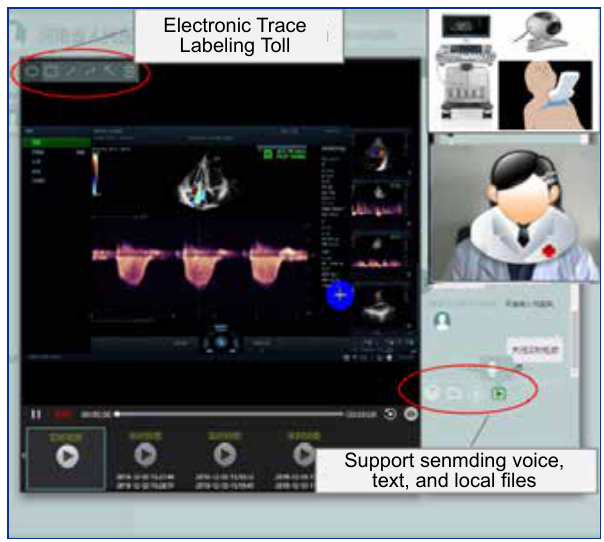
Figure 2 Consultation image of remote echocardiography based on cloud service. During the consultation, voice, video and ultrasonic images are transmitted simultaneously, and the two sides can communicate in real